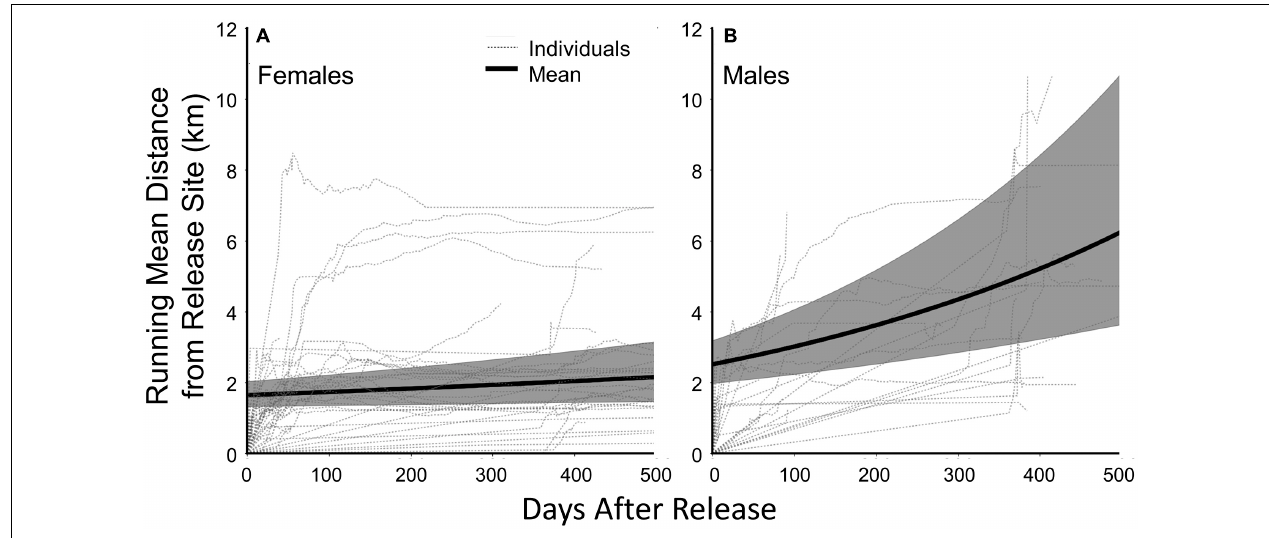
FIGURE 4 | Running mean distances from the sites of trapping and release for (A) female fishers and (B) male fishers born on the study site in northern California from 2011 through 2017 and the fitted mean curves for female and male fishers through time (solid black line; shaded areas are 95% Confidence Limits). Fitted mean line from parameter estimates from a generalized linear mixed model estimating change in distance after